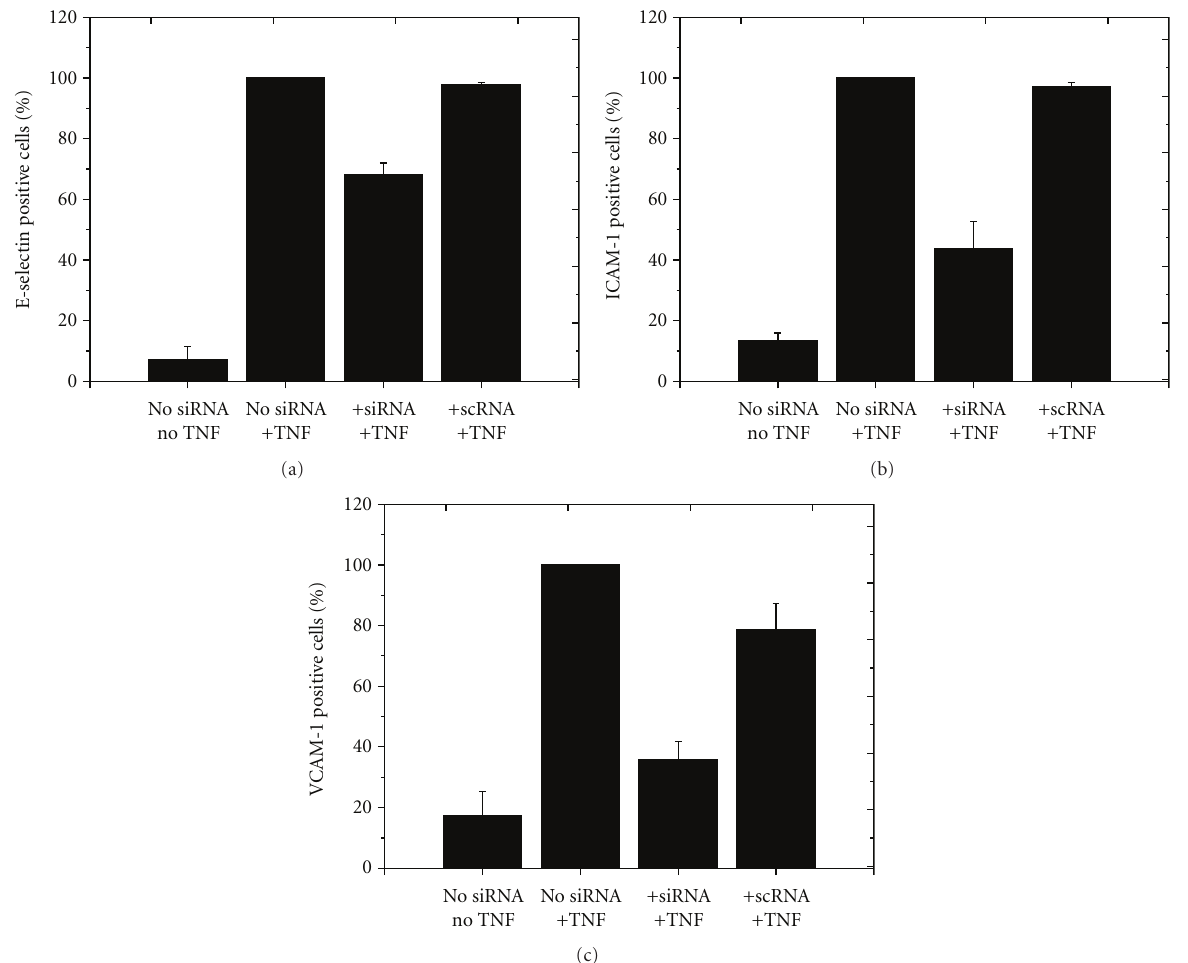
Figure 2: E ff ects of siRNA and TNF treatment on the fraction of cells positive for ESELE, ICAM-1, and VCAM-1. The y -axis reflects the respective adhesion receptor expression (in %), whereby untreated cells stimulated with TNF- α (group 2) were set to 100%. x -axis: group 1: HLMVECs without siRNA transfection and without TNF- α stimulation; group 2: HLMVECs without siRNA transfection, but with TNF- α stimulation; group 3: HLMVECs transfected with a receptor-specific siRNA and with TNF- α stimulation; group 4: HLMVECs transfected with a nonspecific siRNA and with TNF- α stimulation. Each bar represents the mean ± SD of n = 3 independent